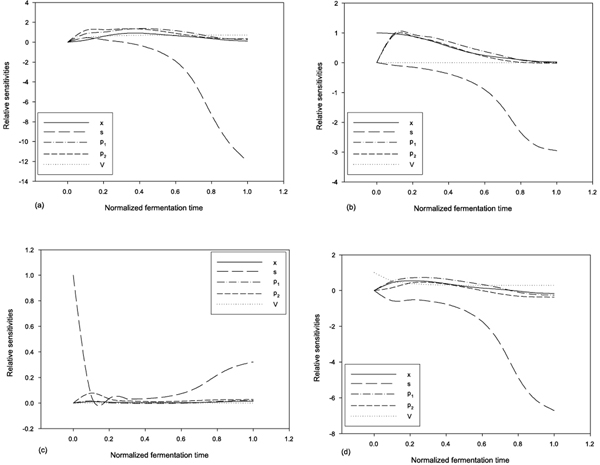
Dynamic relative sensitivities with respect to t
f
, x(0), s(0), and V(0). (a) relative sensitivities with respect to t
f
; (b) relative sensitivities with respect to the initial value of x; (c) relative sensitivities with respect to the initial value of s; (d) relative sensitivities with respect to the initial value of V. The horizontal scale is in normalized fermentation time (t/t
f
).